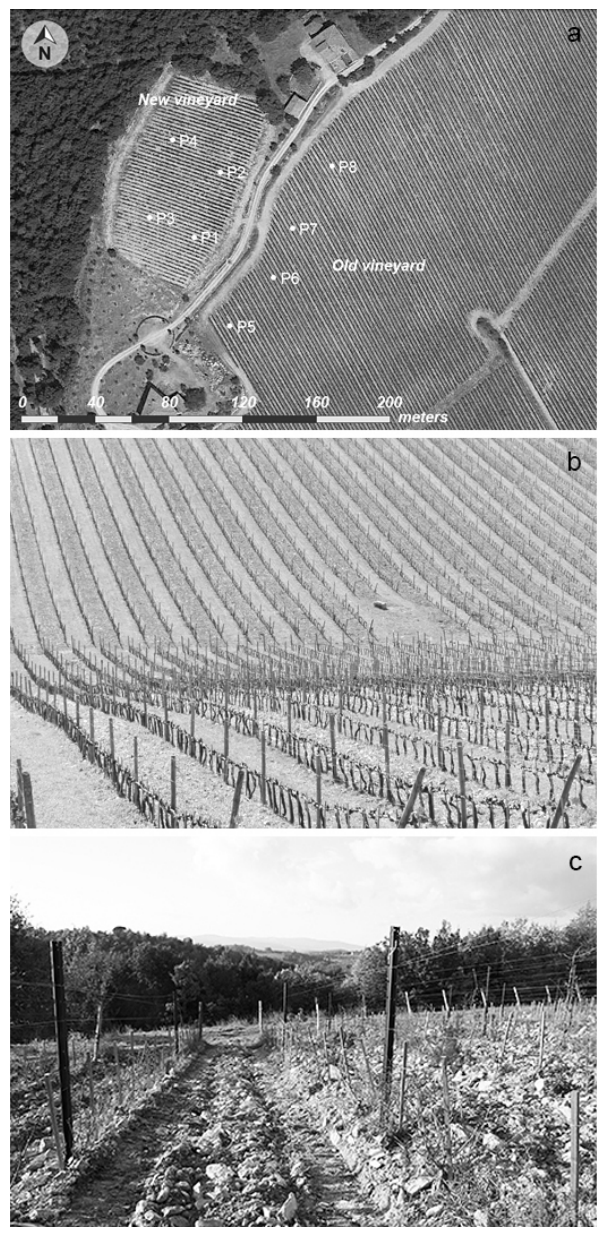
Figure 1. The old ( a , b ) and the new ( a , c ) vineyards with their respective monitoring plots (P1–P5 in the new vineyard, P6–P8 in the old